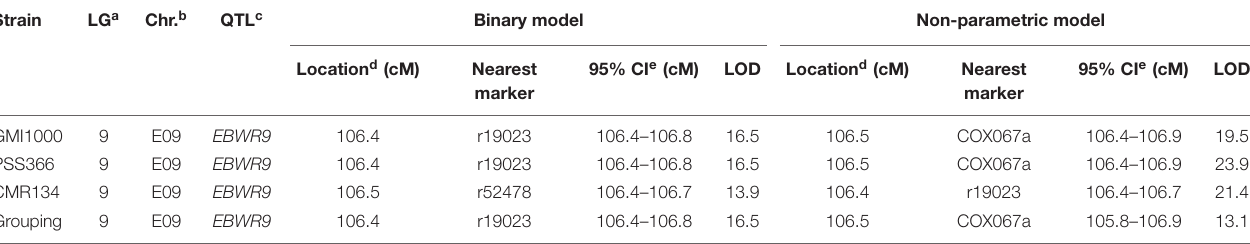
TABLE 4 | QTLs of resistance to three phylotype-I strains of R. solanacearum species complex (GMI1000, PSS366, CMR134), detected by Simple Interval Mapping in eggplant [MM738 × AG91-25] RIL population for the Waudpc variable. Strain LG a Chr. b